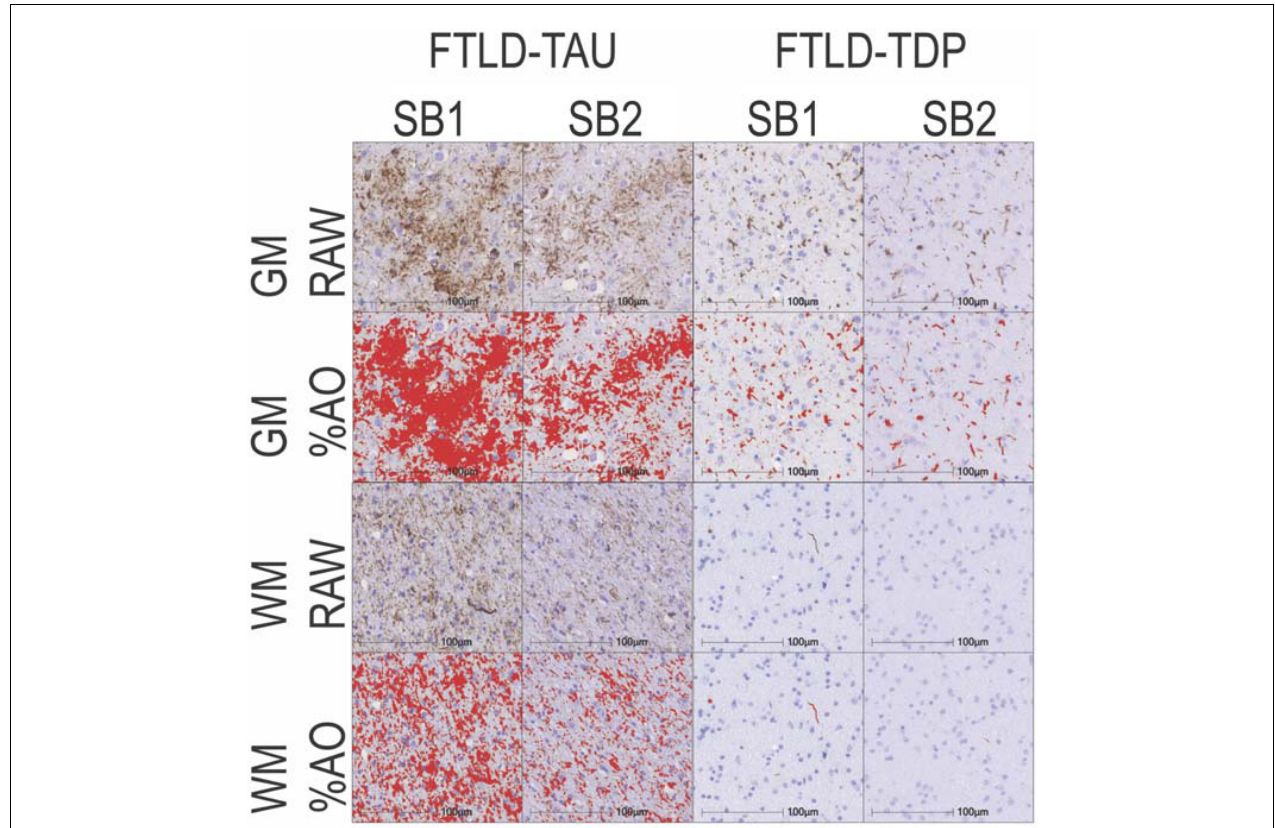
FIGURE 2 | Representative photomicrographs of staining batch variability in FTLD-Tau and FTLD-TDP. Photomicrographs depict a mid-frontal cortex section of FTLD-Tau (Corticobasal degeneration; left) and FTLD-TDP (TDP type A; right) with raw and digital %AO detection red overlay of pathology in gray matter (top) and white matter (bottom) in approximate matched areas in staining batch 1 (SB1) vs. staining batch 2 (SB2). There is slightly darker DAB chromogen signal and thus greater %AO in SB1 compared to SB2. Scale bar = 100 µ m. FTLD-Tau, frontotemporal lobar degeneration with inclusions of the tau protein; FTLD-TDP, frontotemporal lobar degeneration with inclusions of the transactive response DNA-binding protein 43 kDa; GM, gray matter; SB1, staining batch 1 (original); SB2, staining run 2 (new); WM, white